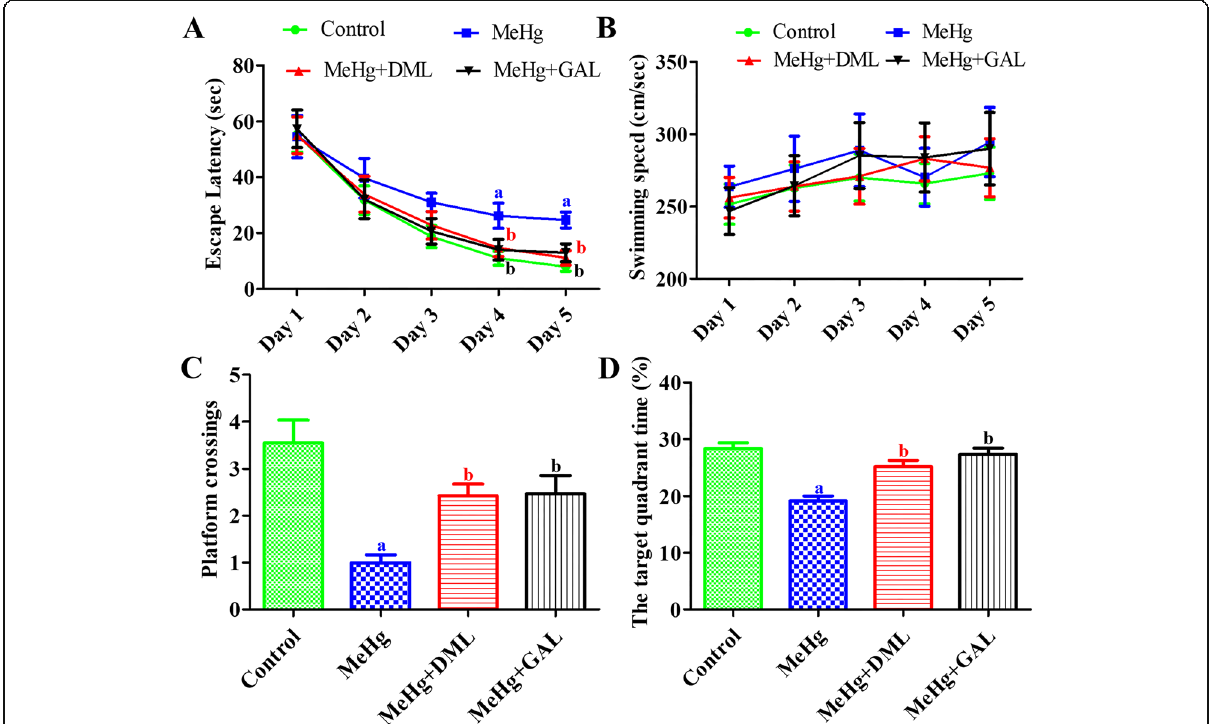
(Fig. 4e, f, g, and h). In the MeHg+DML-treated group, the number of DCX immunoreactive neuroblasts and DCX immunoreactivity were significantly increased by 152.8 and 170.5% than that in the MeHg-treated group, respectively (Fig. 4i and j). In the MeHg+GAL-treated group, similar number and immunoreactivity of DCX positive neuroblasts were observed in the dentate gyrus compared to that in the MeHg+DML-treated group (Fig. 4i and j).